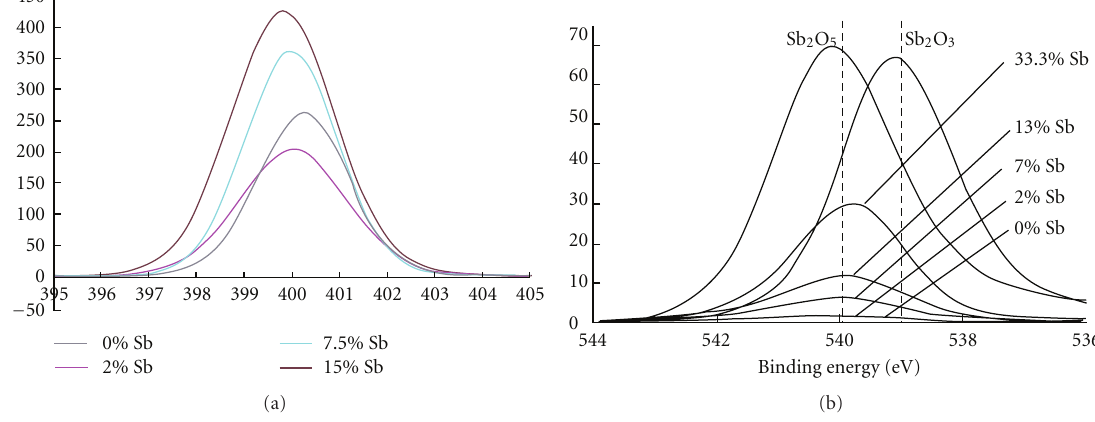
Figure 9: (a) XPS spectra of the N 1s band of the Sb:SnO 2 nanoparticles; (b) XPS spectra of the Sb 3d 3 / 2 of several Sb :SnO 2 nanoparticles.